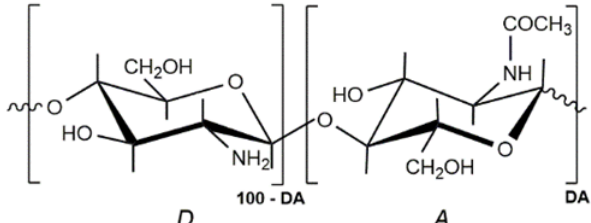
Figure 1. Structural units of chitin and chitosan. (A) N -acetylglucosamine unit; (D) Glucosamine unit. In chitosan DA < 50.